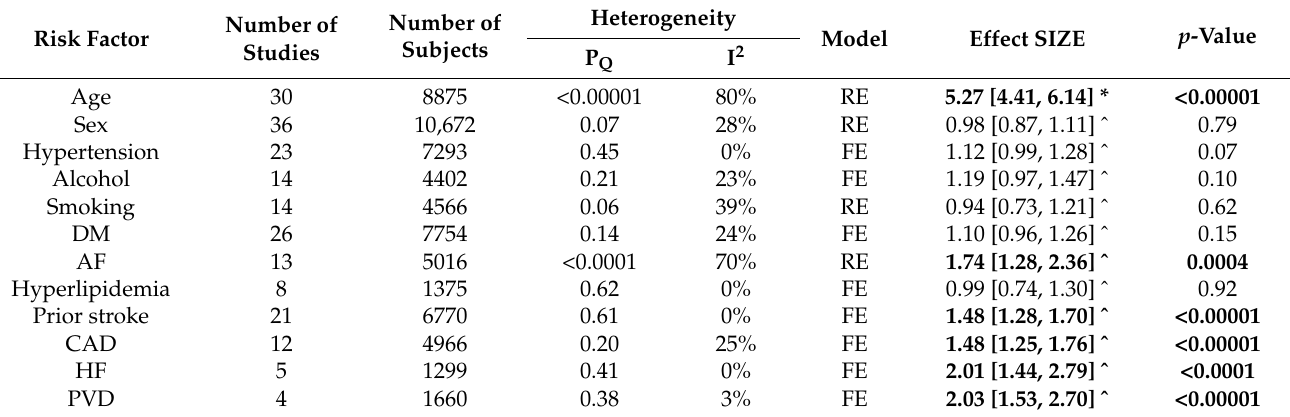
Table 1. Summary of results of the current